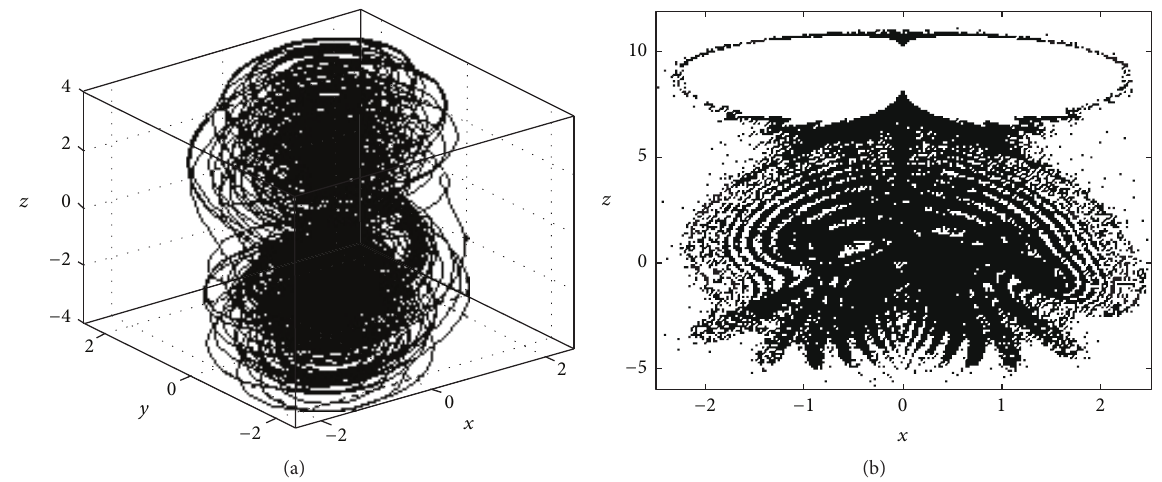
Figure 2: (a) Time history and (b) Poincar´e map in 𝑥 − 𝑧{𝑦 = 0} plane of chaotic system